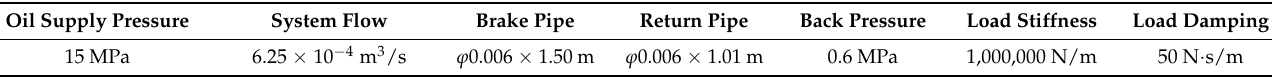
Table 3. Basic parameters of the experimental platform.